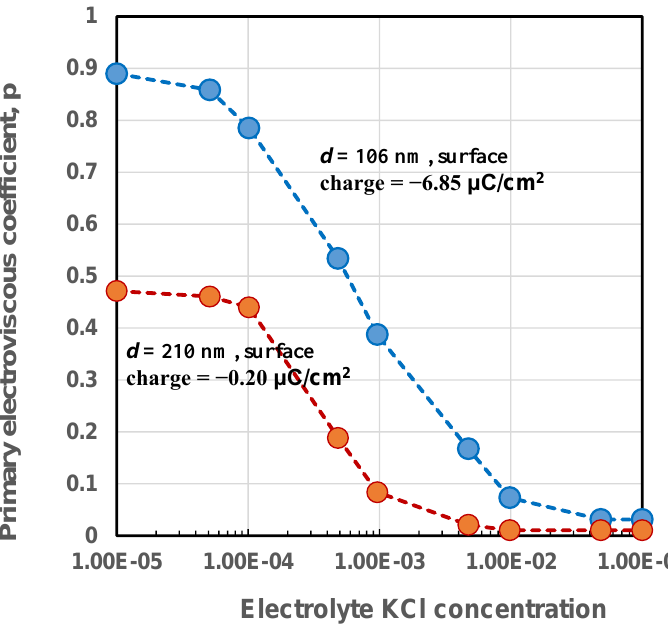
Figure 5. Variation of primary electroviscous coefficient p with electrolyte concentration for electrically charged polystyrene latex suspensions.